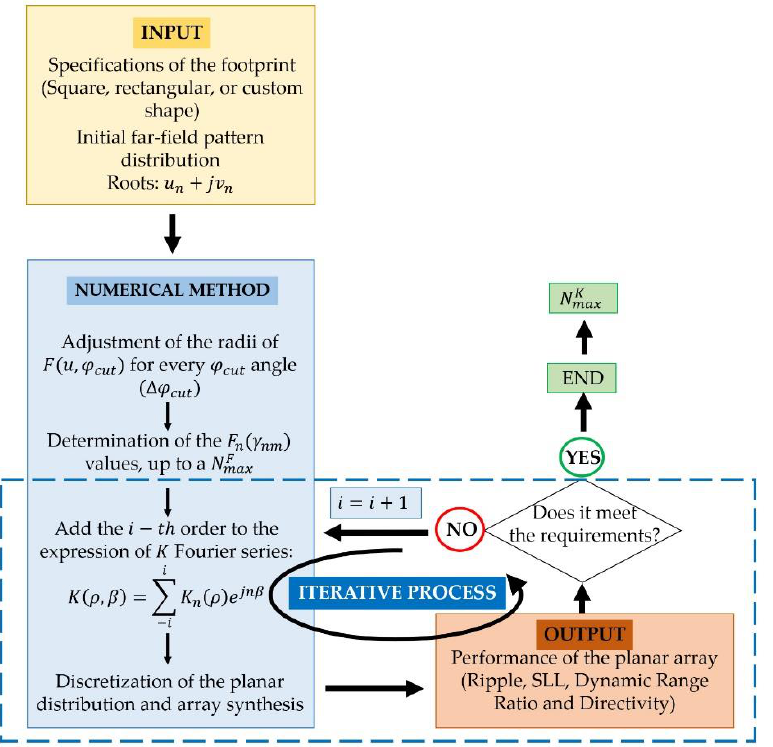
Figure 1. Conceptual flowchart of the procedure for synthesizing a certain footprint pattern.